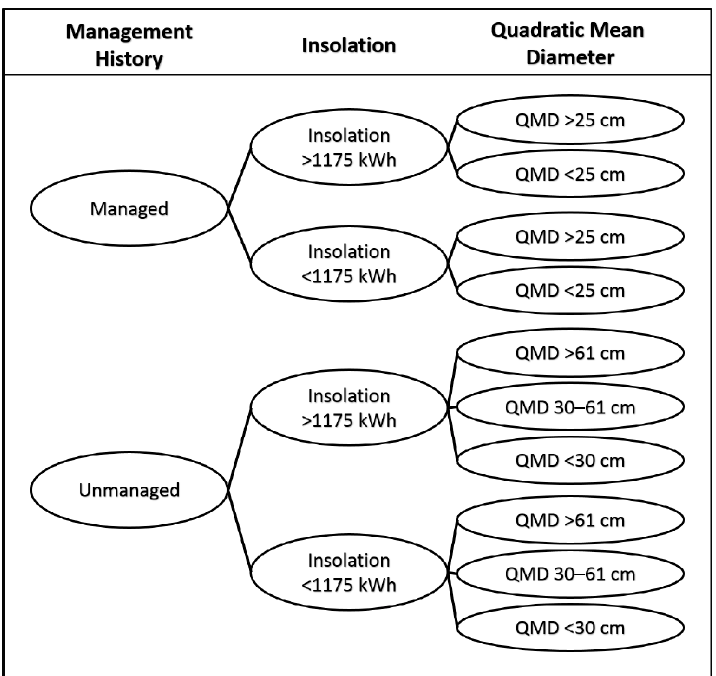
Figure 2. A flowchart showing the stratification of plots is shown.